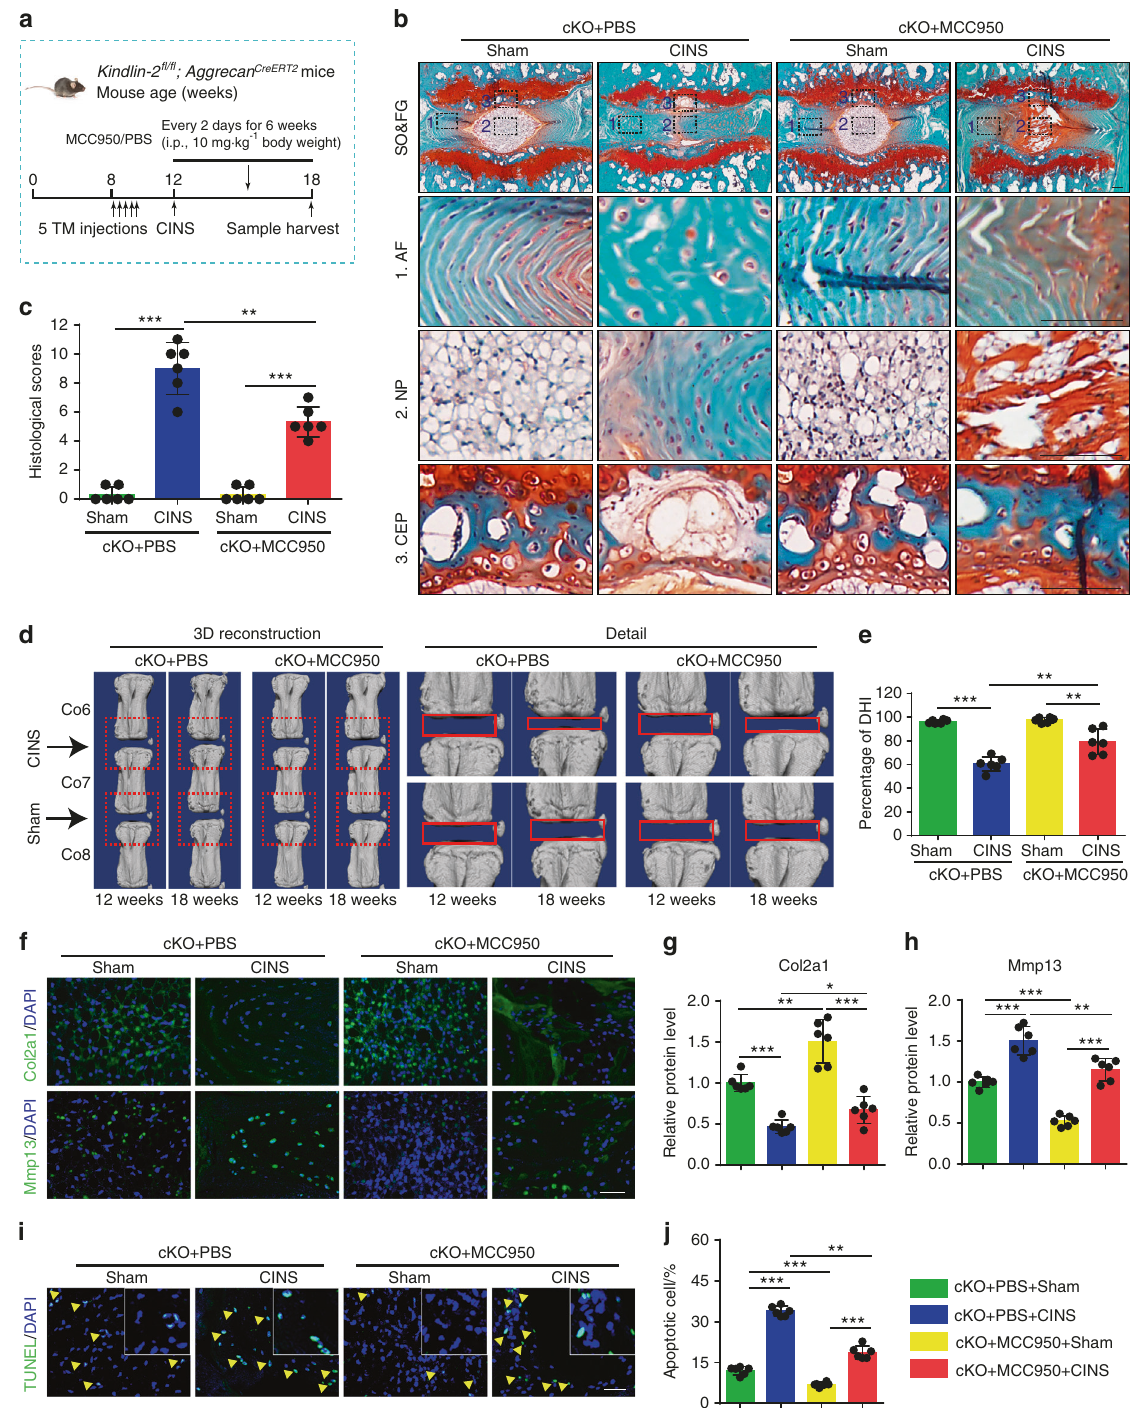
Fig. 5 MCC950 limits IVDD progression caused by Kindlin-2 deletion and abnormal mechanical stress in mice. a Overview of the experimental set-up of coccygeal IVDs needle stab (CINS) model with or without MCC950 treatment. b , c SO&FG staining and histological scores of coccygeal IVDs in control and cKO mice, which were treated with or without CINS, and then treated with or without MCC950. Scale bar, 100 μ m. n = 6. d , e Changes in the disc height index (%DHI) (Co6-7, 7 – 8) were evaluated by micro-computed tomography ( μ CT). n = 6. f – h IF staining of Col2a1 and Mmp13 in NP tissues in coccygeal IVDs of control and cKO mice treated as in ( b ). Scale bar, 50 μ m. n = 6. i , j TUNEL staining of NP tissues in coccygeal IVDs of control and cKO mice treated as in ( b ). Scale bar, 50 μ m. n = 6. * P < 0.05, ** P < 0.01, *** P < Kindlin-2 loss in mice. Consistent with our fi ndings, recent studies Casp1 in dose- and time-dependent manners in NP cells. Third, reported that the dysregulated Nlrp3 in fl ammasome activation is pharmacological inhibition of Nlrp3 in fl ammasome activation linked to the pathogenesis of other chronic diseases, including blocks Kindlin-2 loss induced ECM catabolism and apoptosis in neurodegenerative diseases and degenerative osteoarthritis. 29,30 NP cells in vitro and attenuates the progression of IVDD caused by